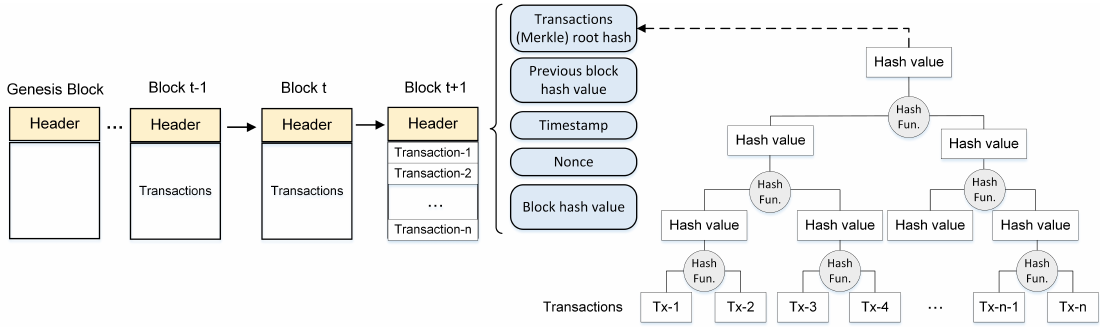
Figure 2. Blockchain